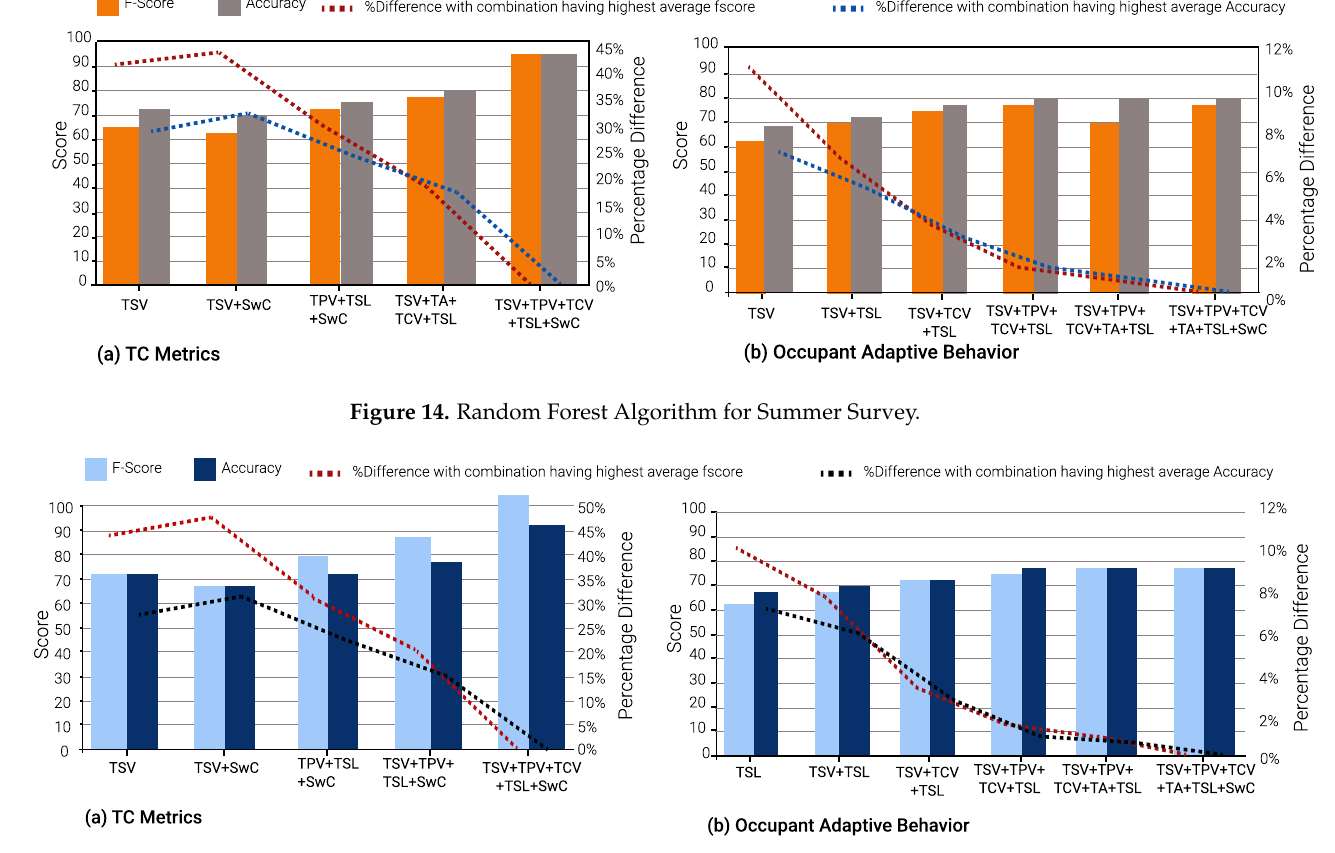
Figure 15. Extreme Gradient Boost Algorithm for Summer